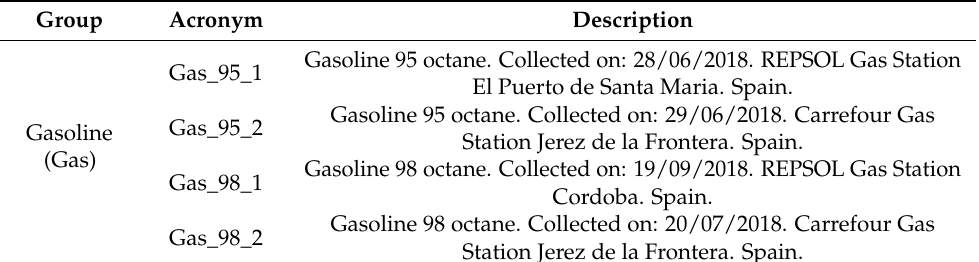
Table 2. Petroleum-derived products used for this